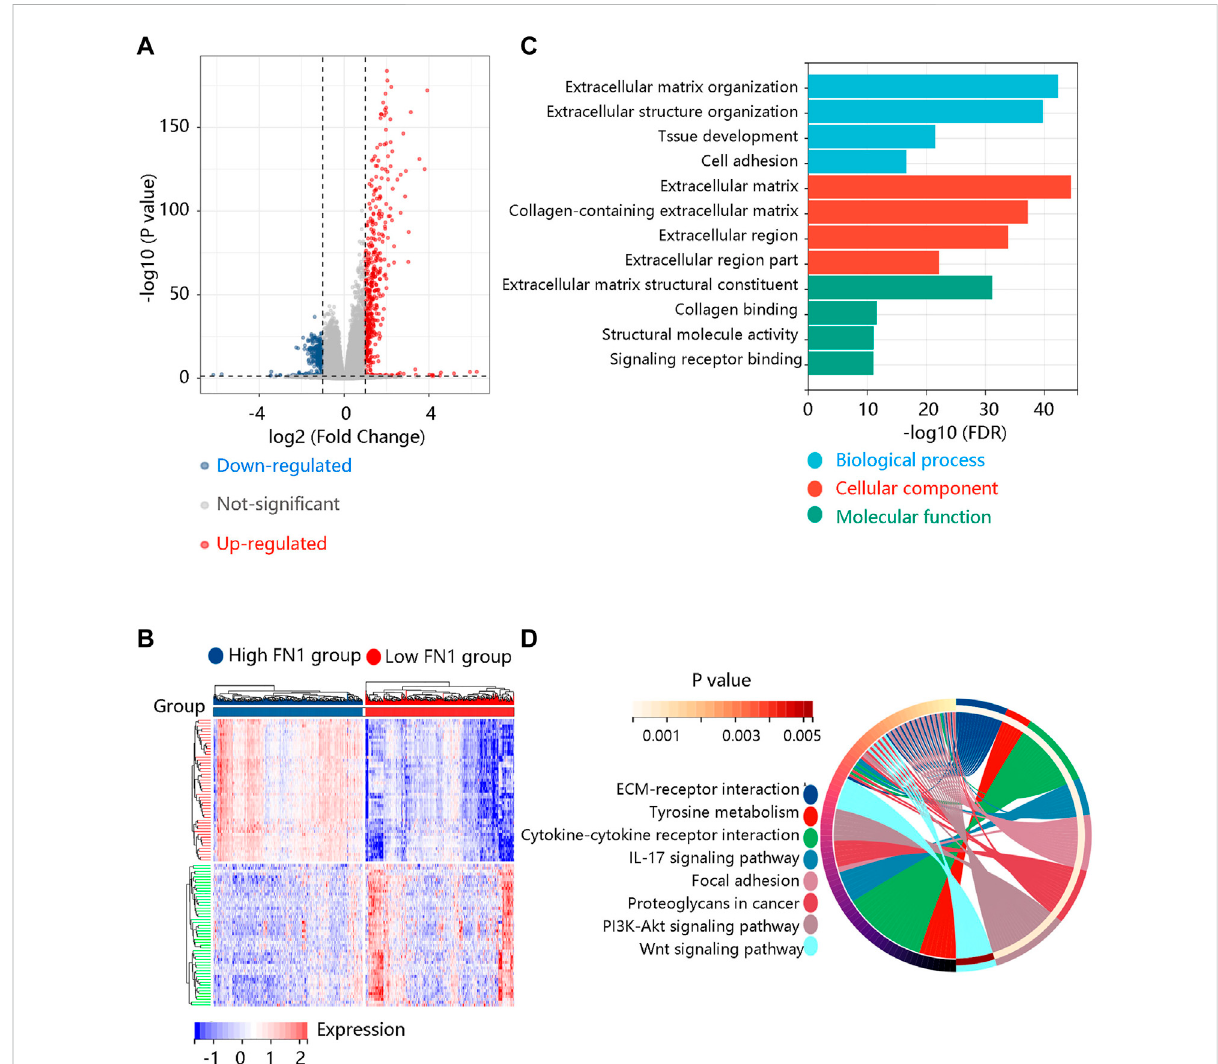
FIGURE 7 Identi fi cation and functional enrichment analysis of the differentially expressed genes (DEGs) betweenhigh and low FN1 expression groups. (A) The volcano plot of the 480 up-regulated and 398 down-regulated DEGs. (B) The heatmap revealed the top 50 DEGs. (C) The gene ontology annotations including biological process, cellular component, and molecular function of the DEGs. (D) The KEGG pathway enrichment of the